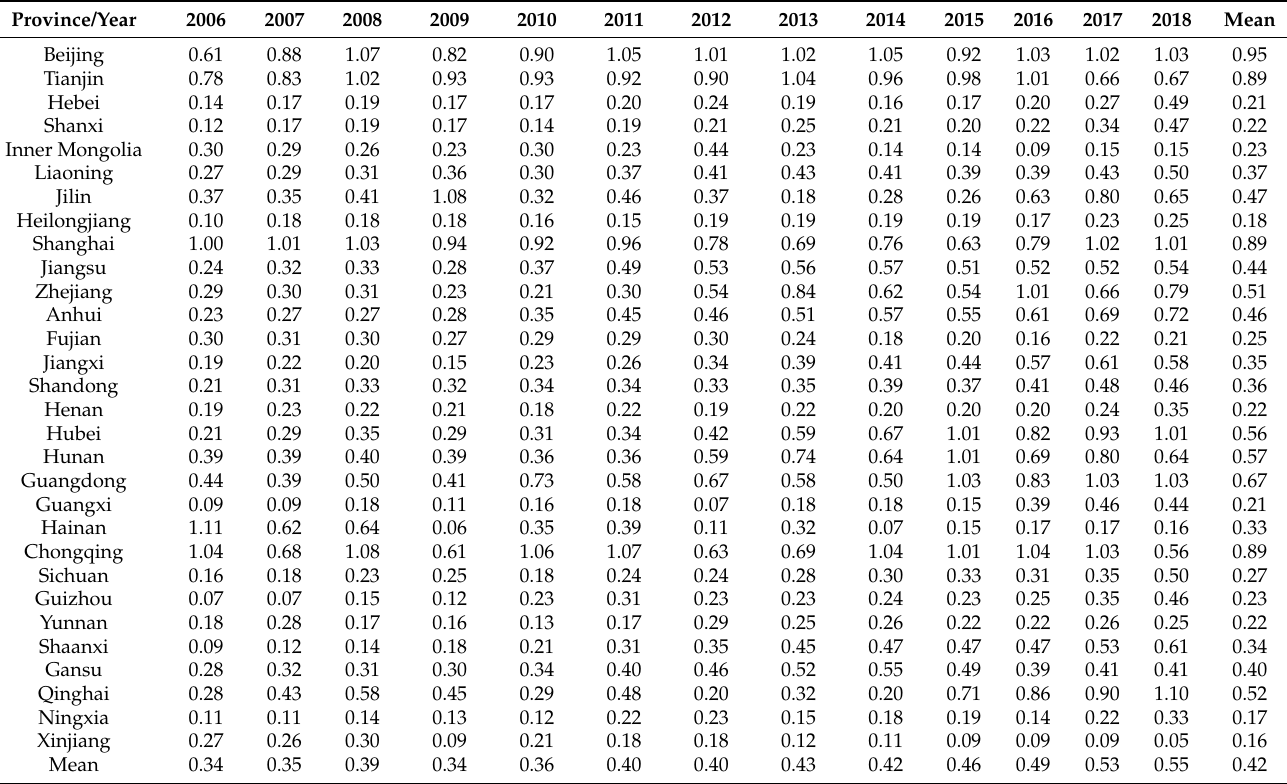
Table 2. The measurement results of GTIE.